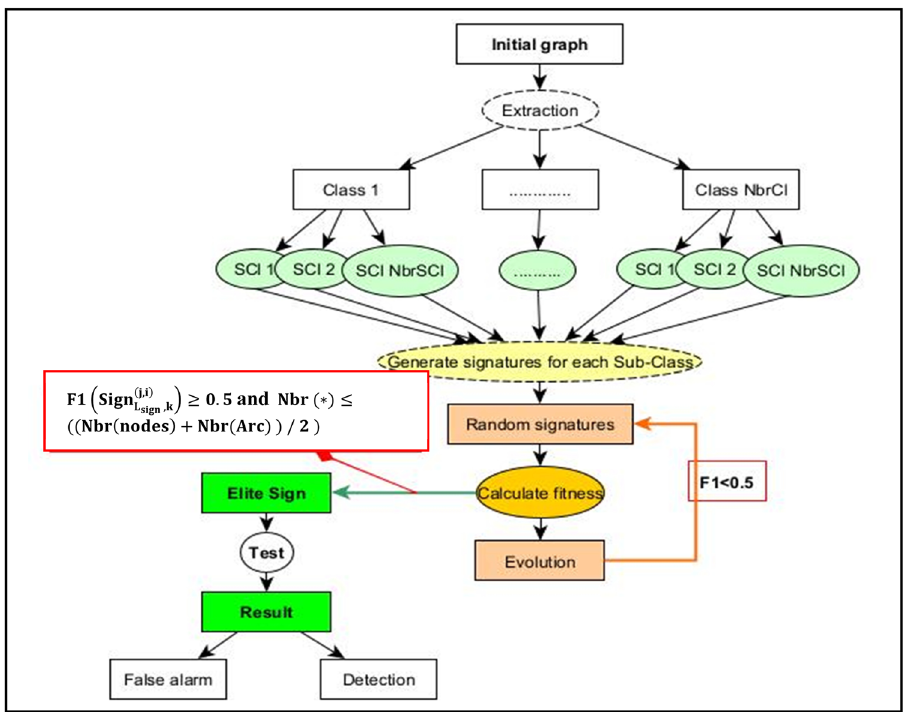
Figure 5: Application of the Genetic Algorithm for information fl ow graph